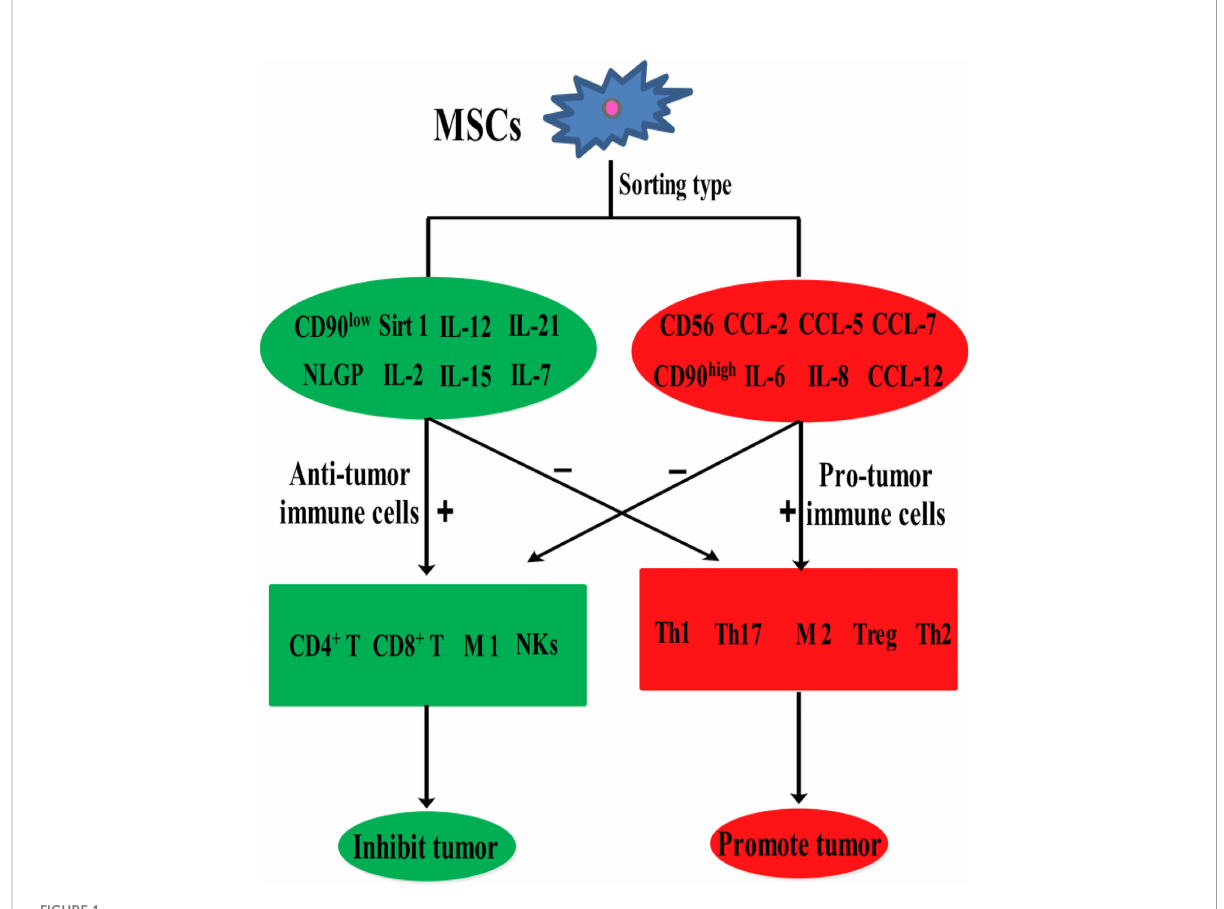
FIGURE 1 The effects of various MSCs subtypes on